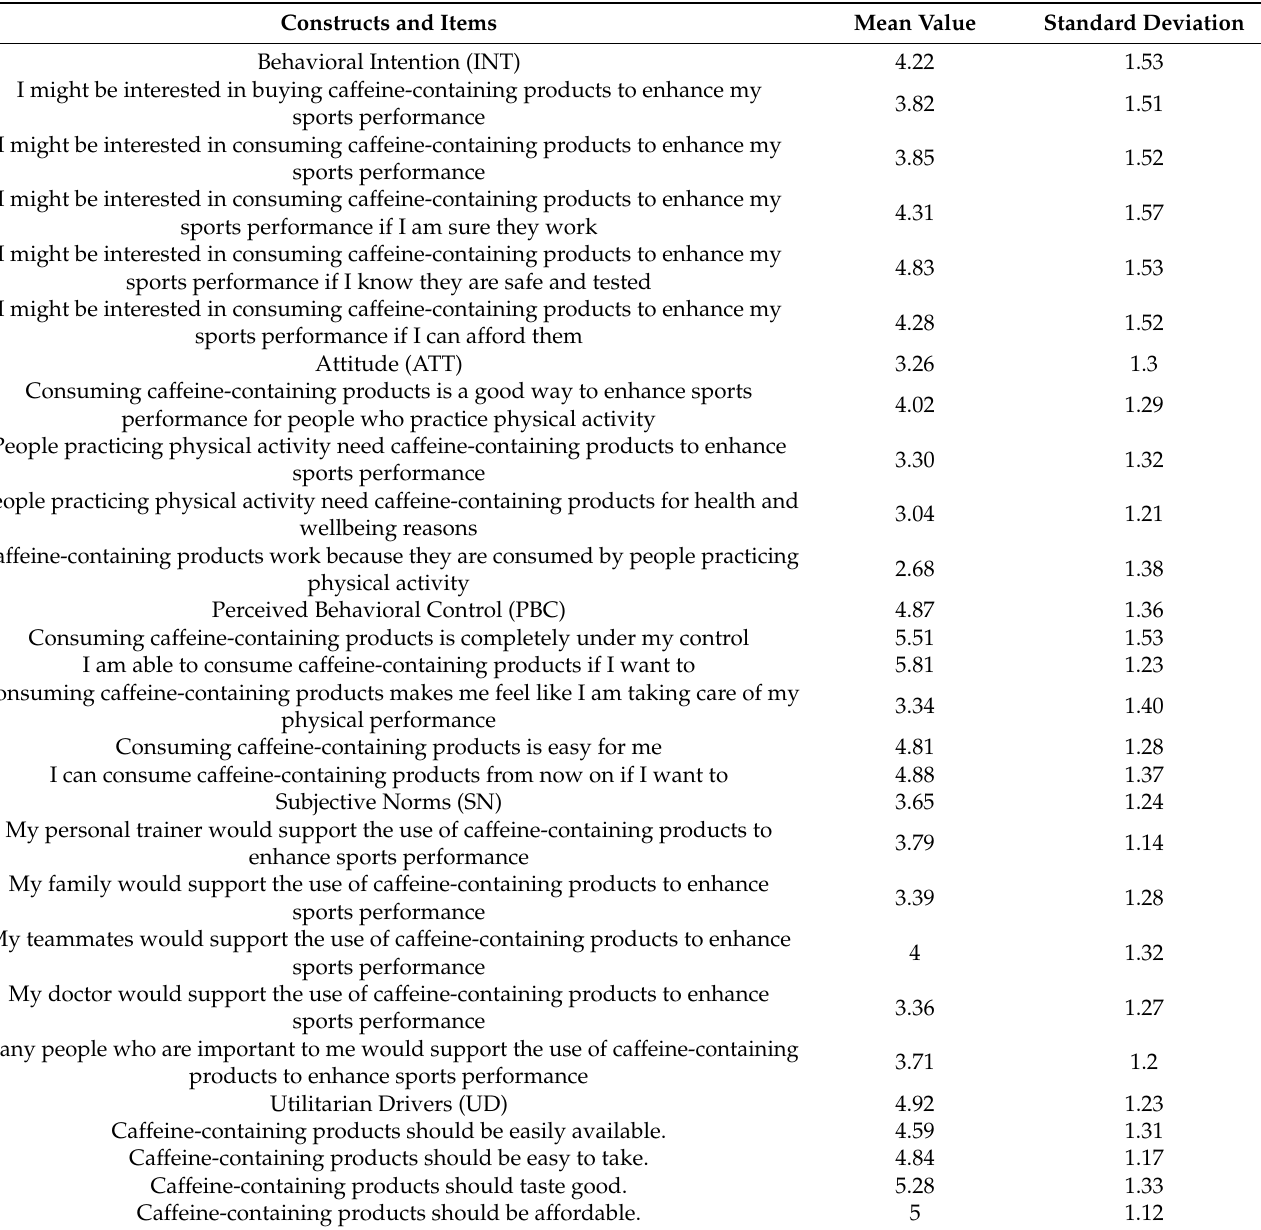
Table 5. TPB constructs and